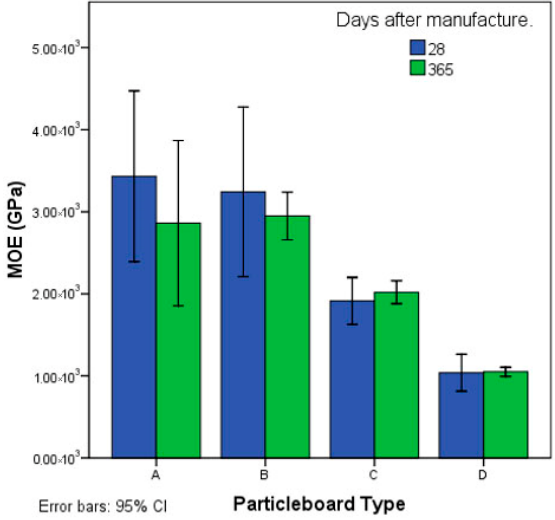
Figure 4. Modulus of rupture (MOR) after 28 and 365 days. CI, confidence interval.